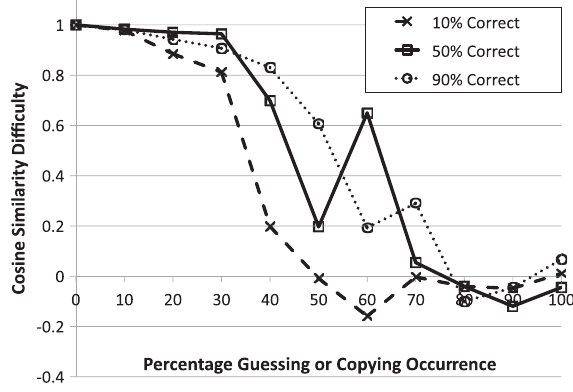
FIG. 8. Cosine similarity of the item difficulties from the “ clean ” exam values as a function of simulated copy or guess occurrence. Values are shown for a success rate of 10% ( “ educated guessing ” ), 50%, and 90% ( “ copying ”